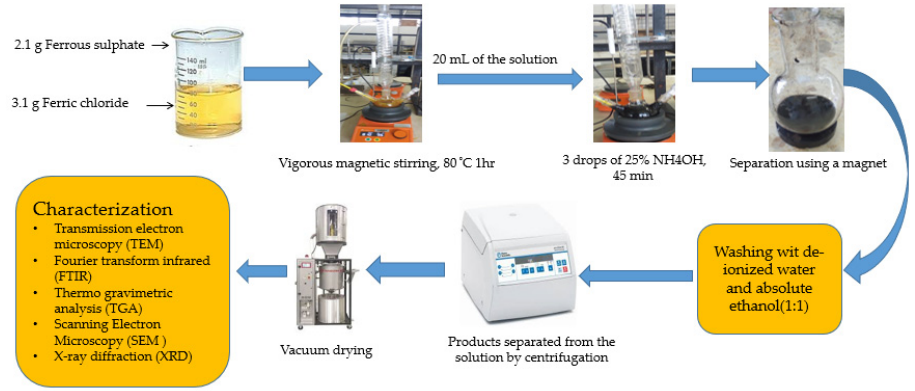
Figure 1. The schematic diagram for the synthesis of MNPs.